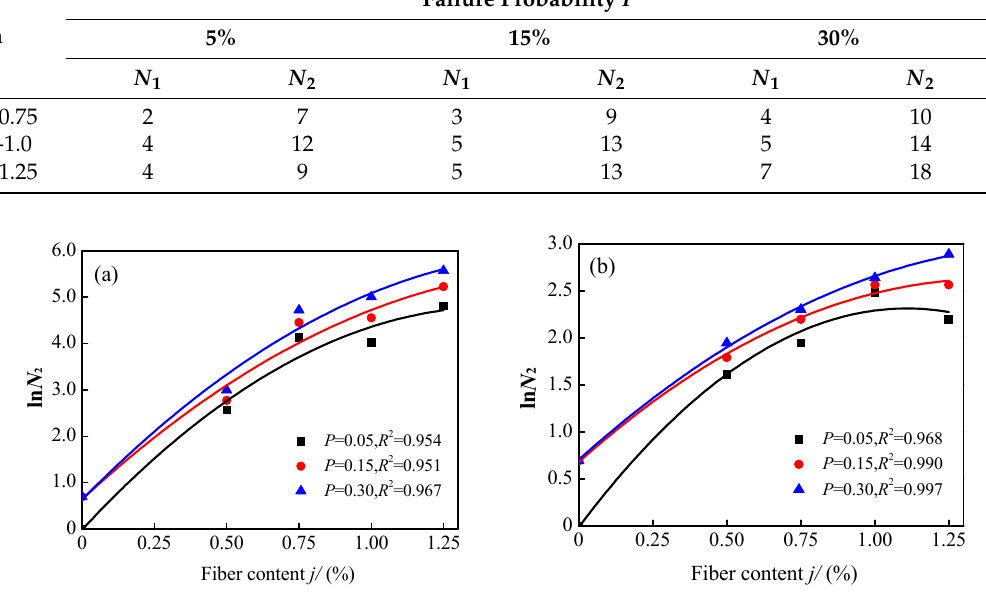
Figure 8. P –ln N 2 – V f curves: ( a ) HFRAC curves in log-normal distribution; ( b ) SFRAC curves in log-normal distribution.